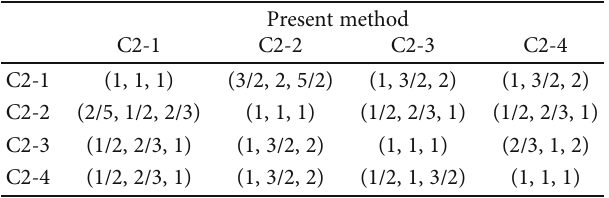
Table 10: The comparison matrix with respect to ecological